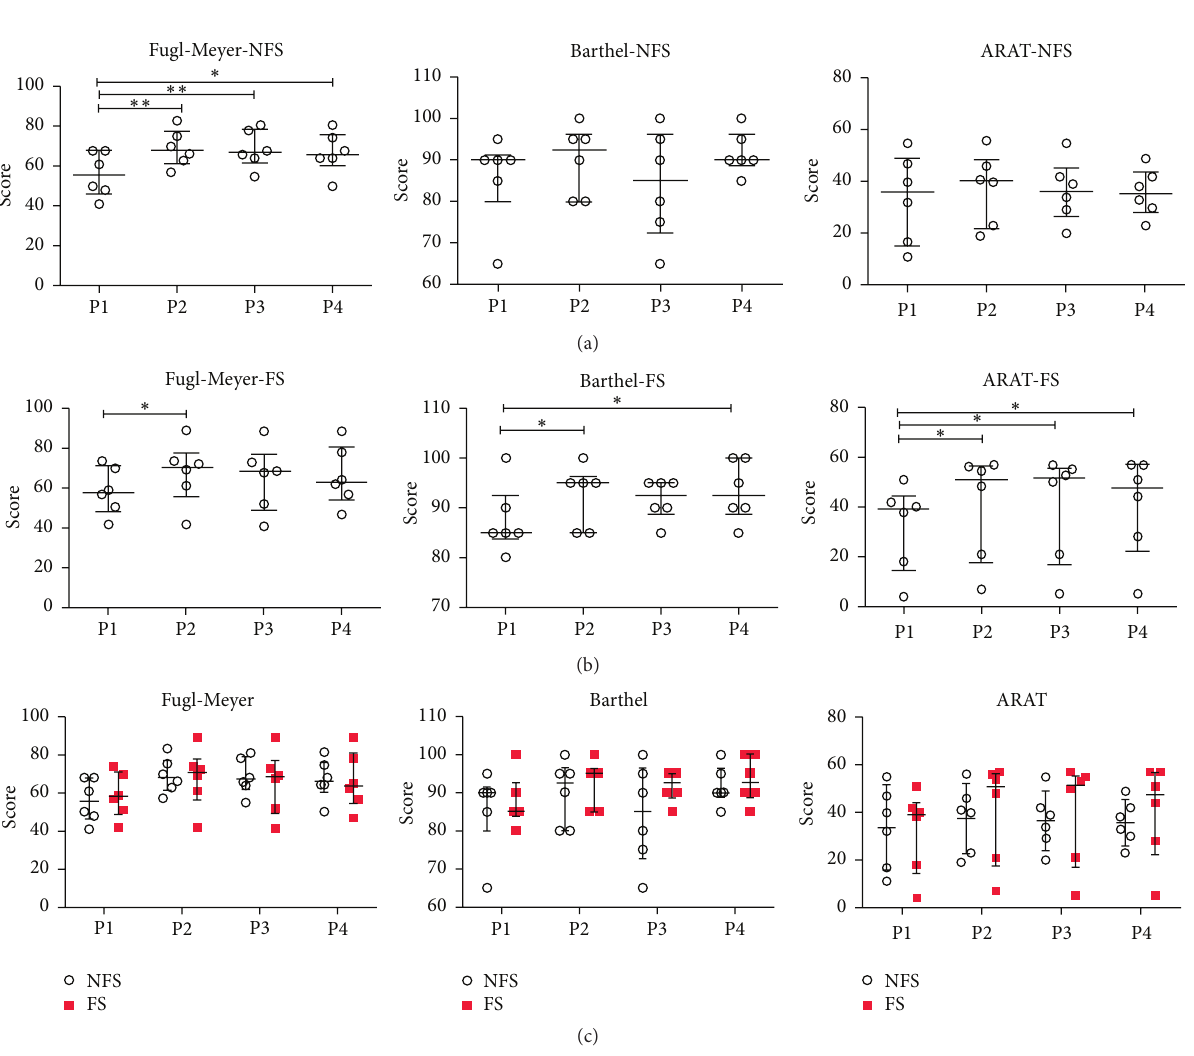
Figure 1: Results of all clinical scales (Fugl-Meyer, ARAT, and Barthel index), for the NFS and FS groups. Values are represented as median and interquartile interval. ∗ 𝑝 < 0.05 ∗∗ 𝑝 < 0.01 based on Tukey post hoc test. (a) shows the results for the clinical scales in the NFS group, before rehabilitation (P1), immediately after rehabilitation (P2), 1 month after the end of rehabilitation (P3), and three months after the end of rehabilitation (P4). (b) shows the results of clinical scales in the FS group. (c) shows the between-group comparison (NFS × FS) at the different periods of evaluation (P1, P2, P3, and